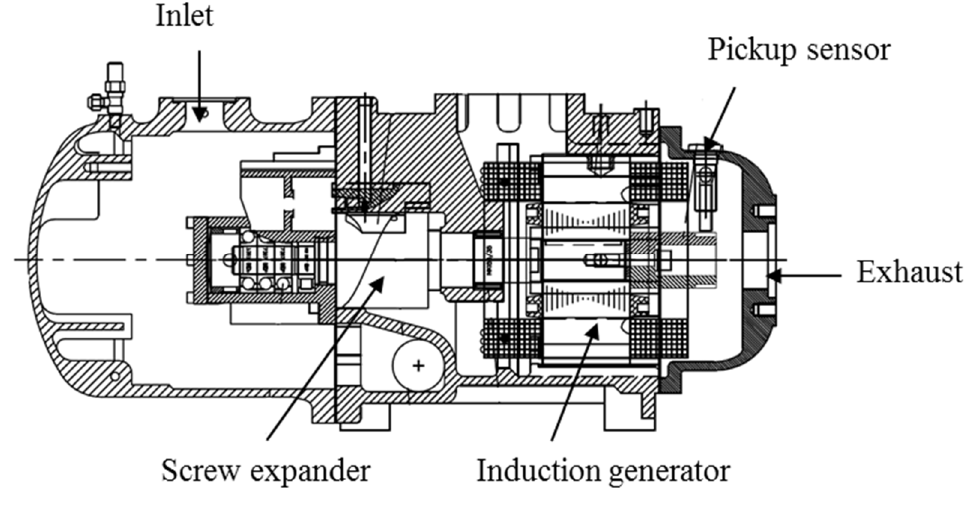
Figure 2. Configuration of a hermetic twin-screw expander integrated with an induction generator.